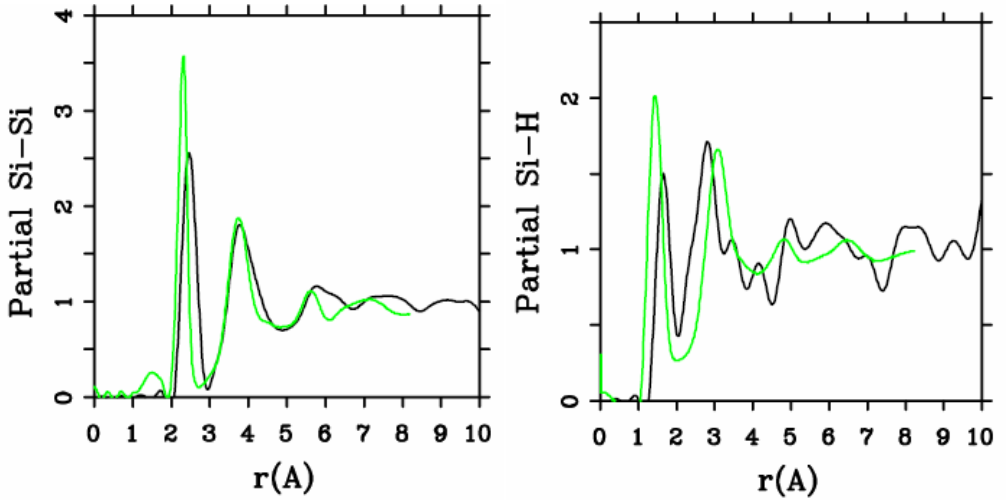
Figure 5. Partial Si–Si and Si–H RDFs for the hydrogenated 2.44/0.46 cell. The black lines are our simulation and the green lines are the experimental results.